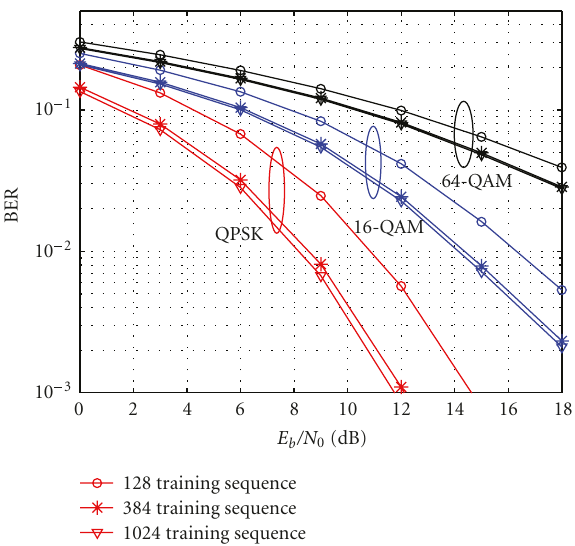
Figure 8: Uncoded BER performance for FB-FSE (AP-FBEQ Case 3 equalizer) with 2 M = 256 subbands and di ff erent K -factors.